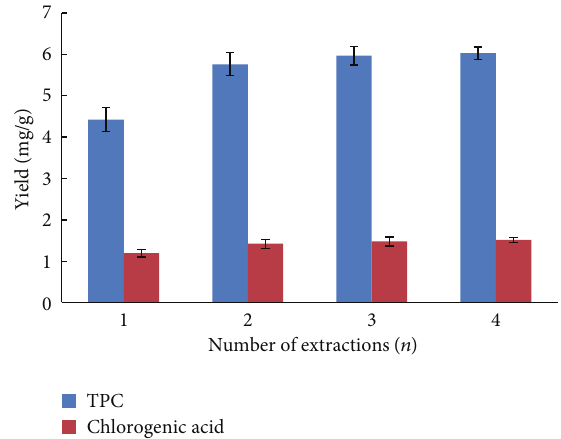
Figure 4: Effect of ultrasonic time on TPC and chlorogenic acid yield (ethanol concentration, 25%; solid-liquid ratio, 1:20; number of extractions, 1; 𝑛 = 5